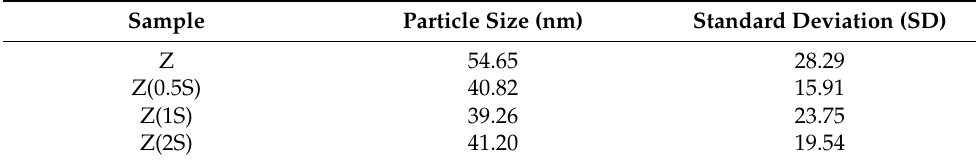
Table 2. Particle sizes of pristine and modified ZnO NPs.